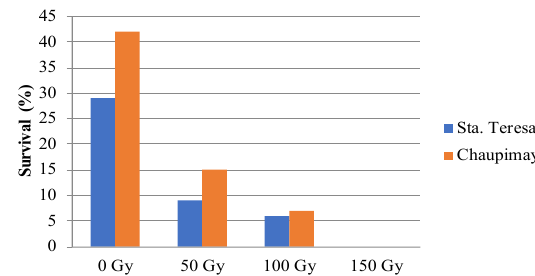
Figure 4. Percentage of survival of germinated coffee ( Coffea arabica L. var. typica) seeds originating from Santa Teresa and Chaupimayo under net house conditions at 112 days after sowing following irradiation with gamma rays at 0 (control), 50, 100, and 150